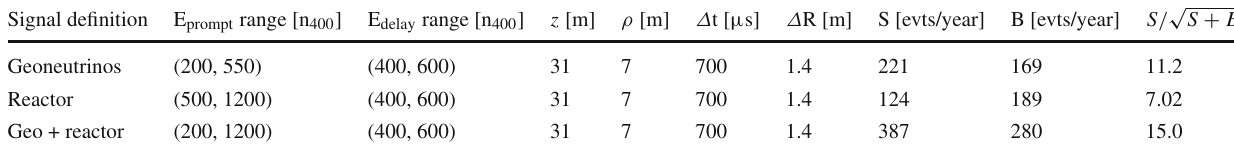
Table 8 Results of ROI optimization in the phase space of selection cuts necessary for antineutrino candidates selection Signal